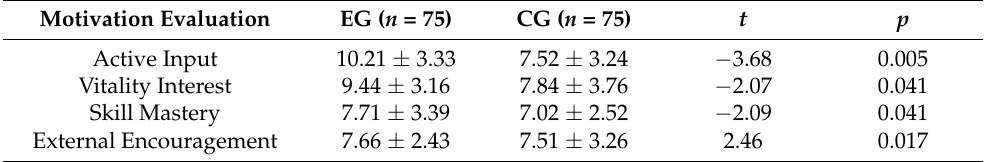
Table 8. Comparison of Motivation Evaluation Variables of EG and CG after Experimental